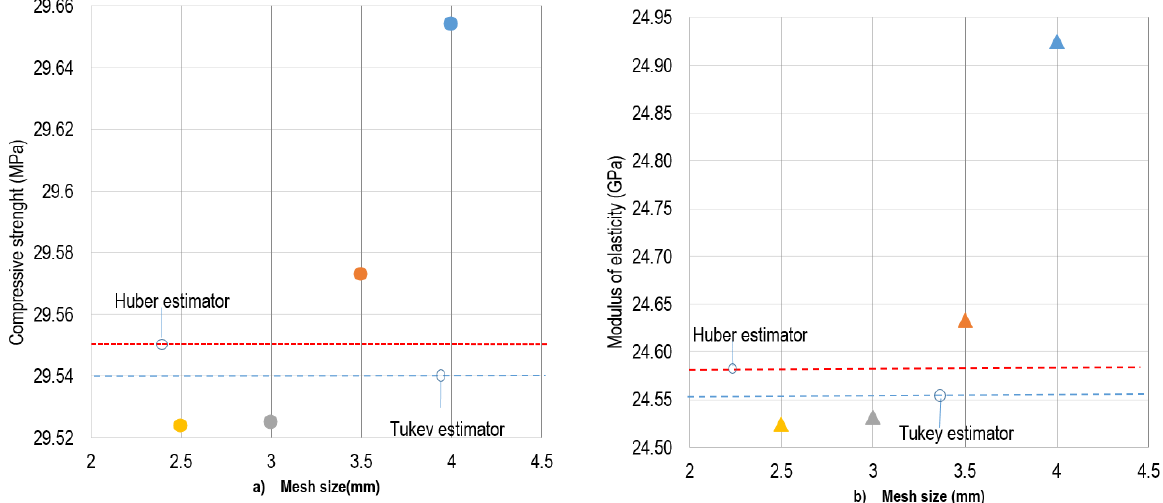
Table 10. Variation of the numerical results, compared to the experimental results.